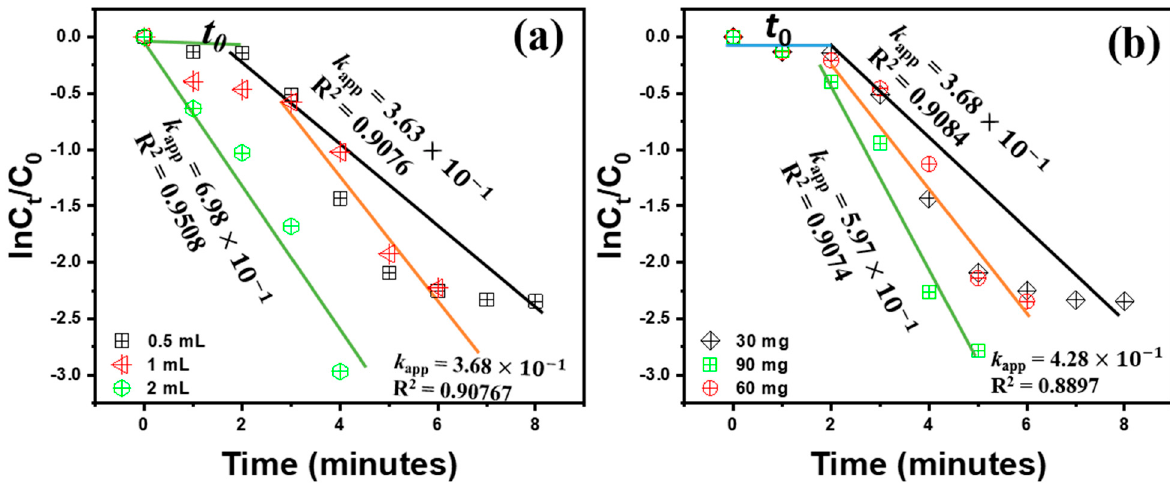
Figure 4. Pseudo first order kinetics plots of CR dye discoloration under the influence of different amount of NaBH 4 (30 mg catalyst, 0.09 mM CR dye) ( a ) and catalyst amount (0.05 mL of 1 mM NaBH 4 solution, 0.09 mM CR dye) ( b ).